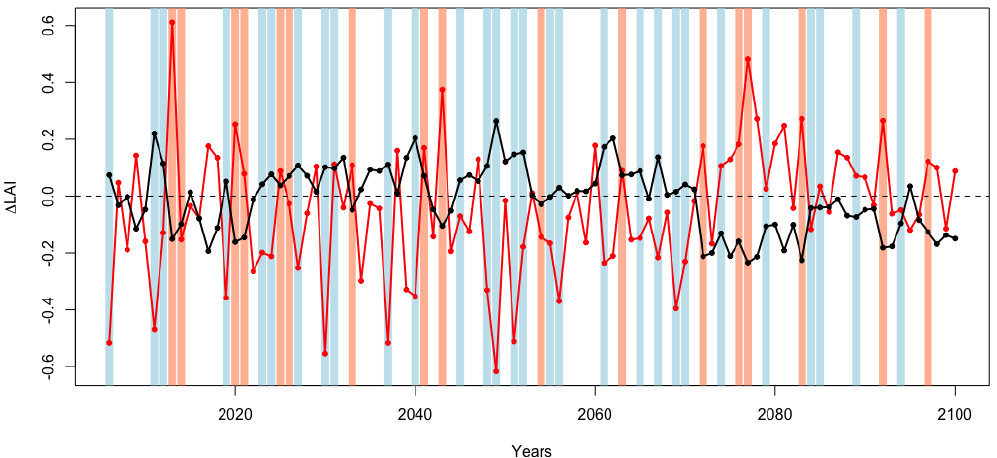
Figure A5. Temporal differences in LAI according to future simulations with and without intensified ENSO contribution ( (cid:49) = with inten- sification − without intensification). Black line: northern transect; red line: southern transect. Vertical blue lines: all moderate ( < − 1.0 ◦ C) La Niña years identified for the future period (2006–2100); vertical pink lines: moderate ( > 1.0 ◦ C) El Niño